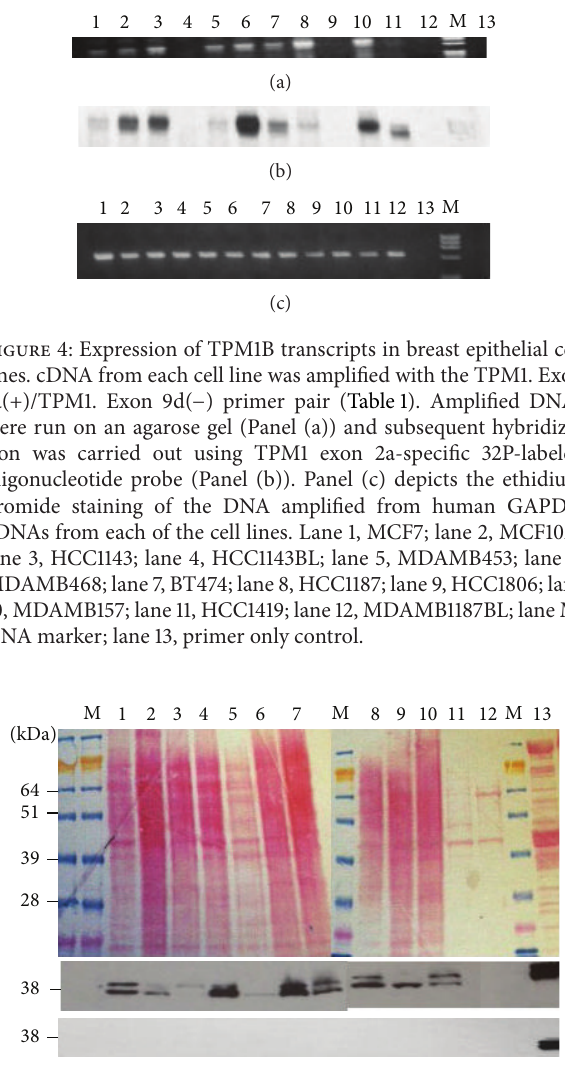
Figure 5: Western blot analyses for tropomyosin protein expressed in various breast epithelial cell lines. Top panel is the west- ern blot stained with Ponceau dye. Middle panel is the blot stained with anti-tropomyosin antibody TM311 that reacts with all tropomyosins containing exon 1a. Bottom panel is the western blot stained with anti-tropomyosin antibody CH1 that reacts with all tropomyosins containing exon 9a. Lane M, molecular weight marker;lane1,MDAMB453;lane2,HCC1419;lane3,HCC1806;lane 4, MDAMB157; lane 5, BT474; lane 6, HCC1187; lane 7, HCC1143; lane 8, MDAMB468; lane 9, MCF7; lane 10, MCF10A; lane 11, HCC1143BL; lane 12 HCC1187BL; lane 13, skeletal